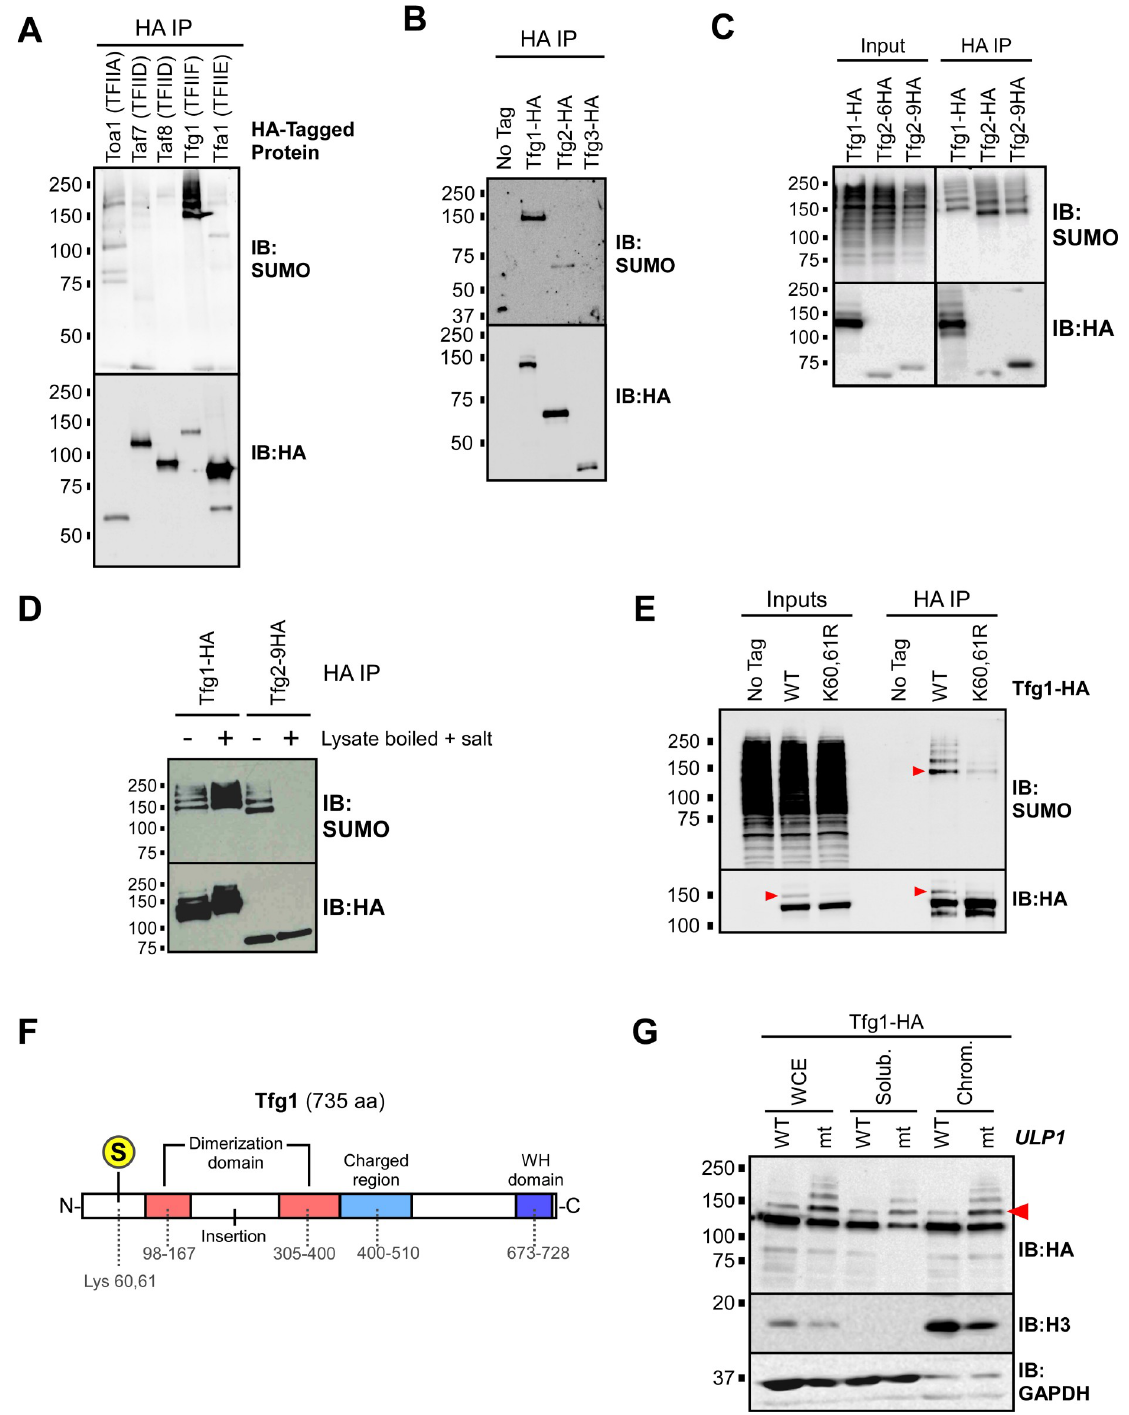
Fig 4. The large subunit of TFIIF, Tfg1, is sumoylated at Lys 60/61. (A) Yeast strains were generated that each express a 6xHA C- terminal epitope tag on a different GTF subunit, including Toa1 (TFIIA), Taf7 (TFIID), Taf8 (TFIID), Tfg1 (TFIIF), or Tfa1 (TFIIE). Cultures of the strains were used to prepare lysates, under non-denaturing conditions, that were then used in HA IP experiments, followed by SUMO and HA immunoblots (IBs). (B) Strains expressing HA-tagged forms of TFIIF subunits Tfg1, Tfg2, or Tfg3 (also known as TAF14), were used for HA-IP experiments followed by SUMO and HA immunoblot analysis. “No tag” refers to the parental strain (W303a) that expresses no HA-tagged proteins. (C) Strains expressing Tfg1-HA, Tfg2-HA, or Tfg2-9HA (with a 9xHA tag instead of the usual 6xHA tag) were used in an HA IP analysis performed with lysates generated under non-denaturing conditions, followed by HA and